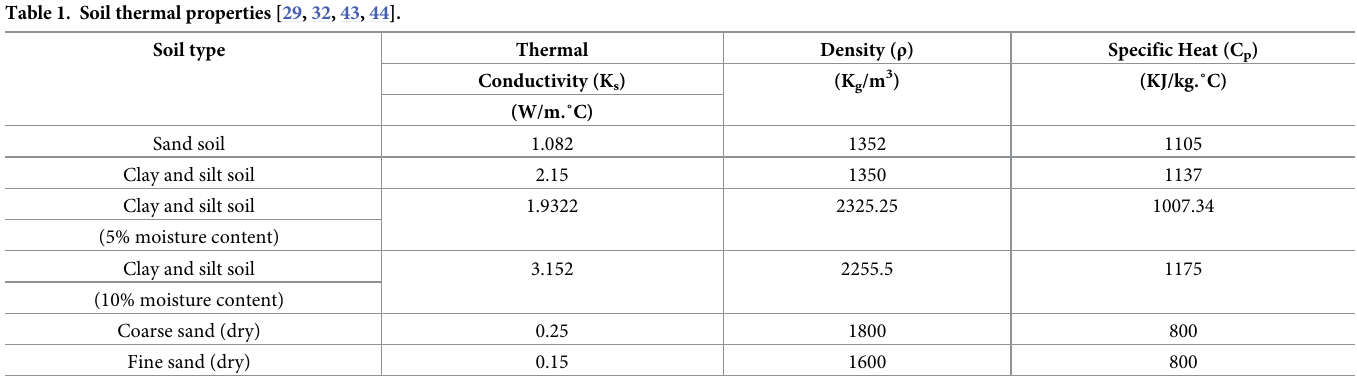
Table 1. Soil thermal properties [29, 32, 43, 44].